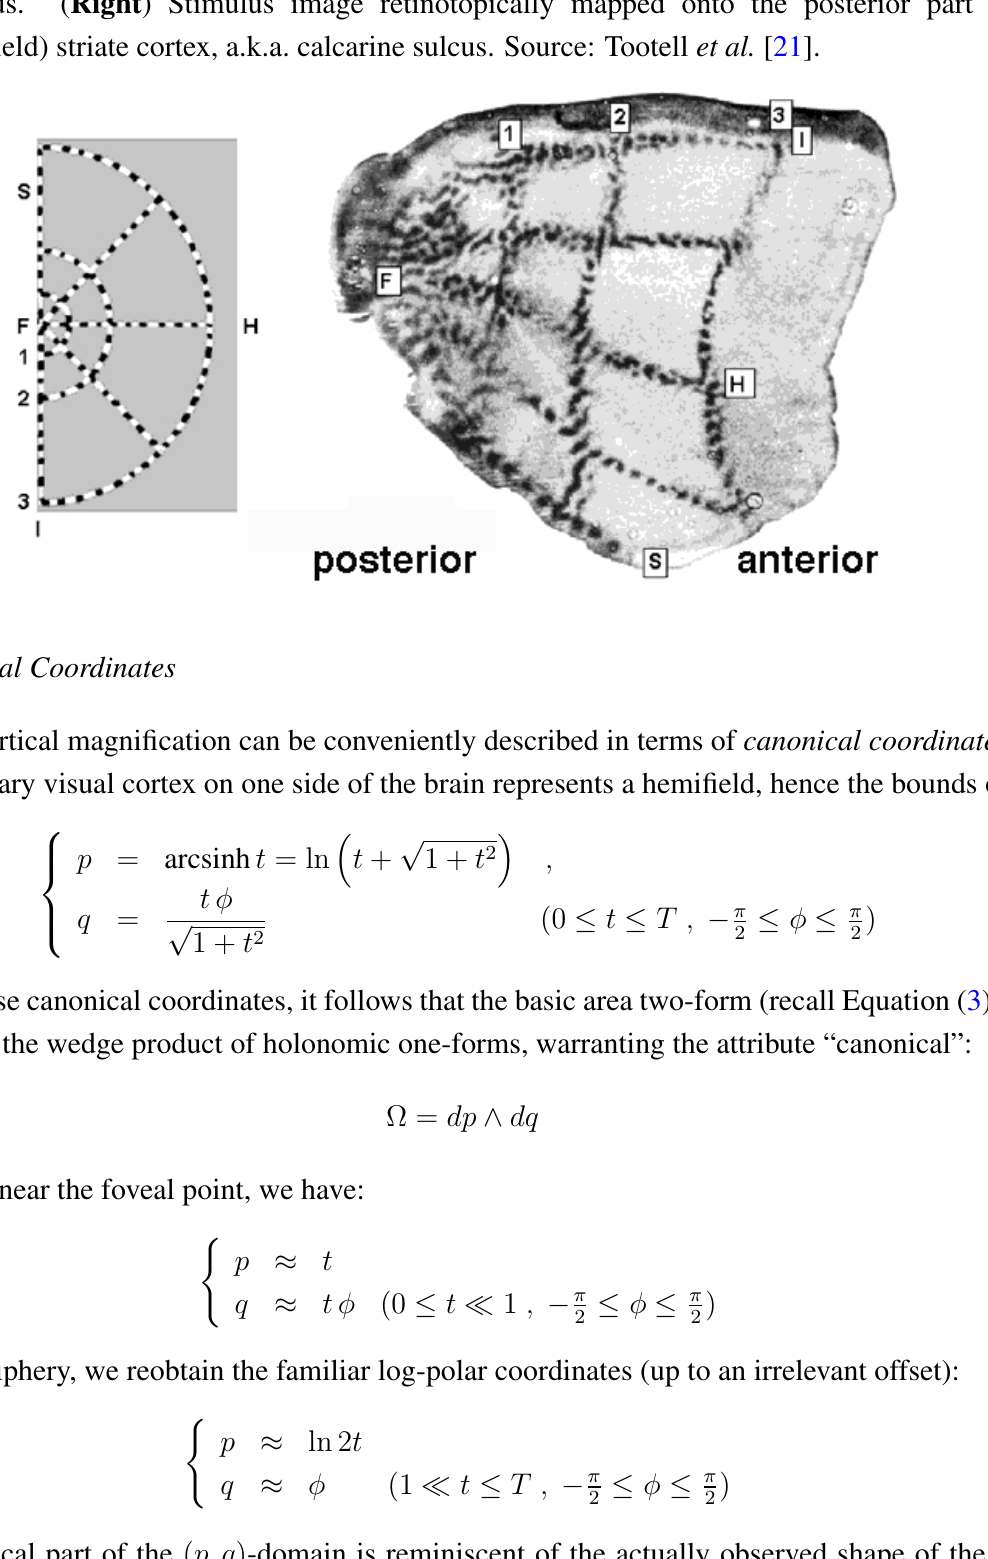
Figure 3. Retino-cortical mapping of macaque monkey. ( Left ) Retina with spoke-wheel stimulus. ( Right ) Stimulus image retinotopically mapped onto the posterior part